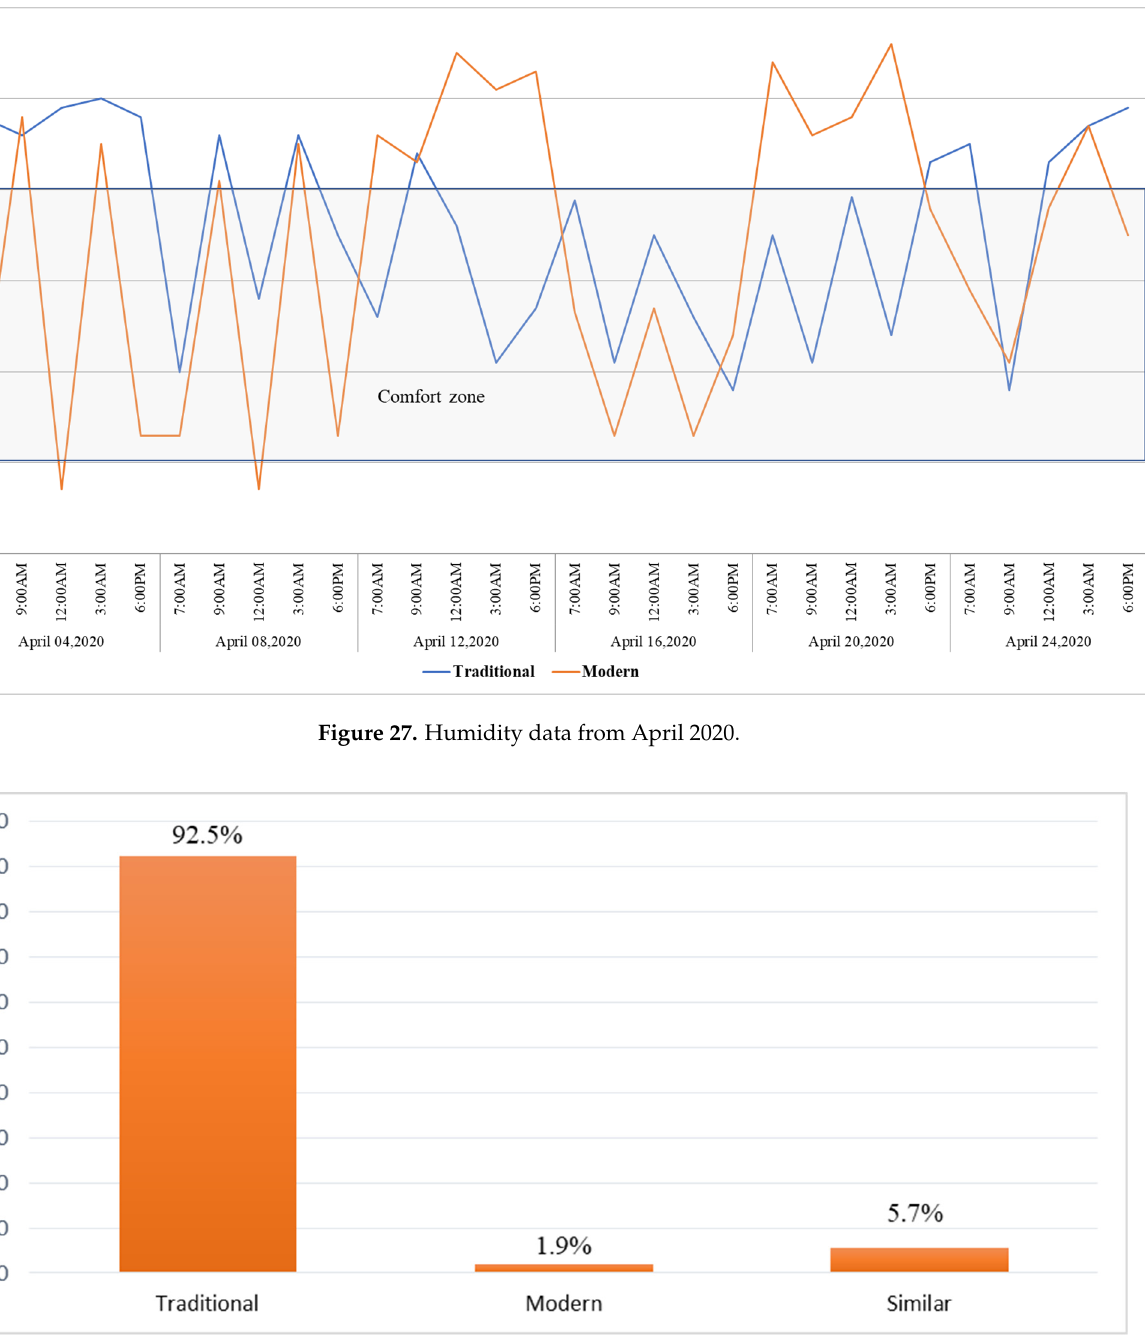
Figure 28. Comparing thermal comfort between traditional and condominium houses .